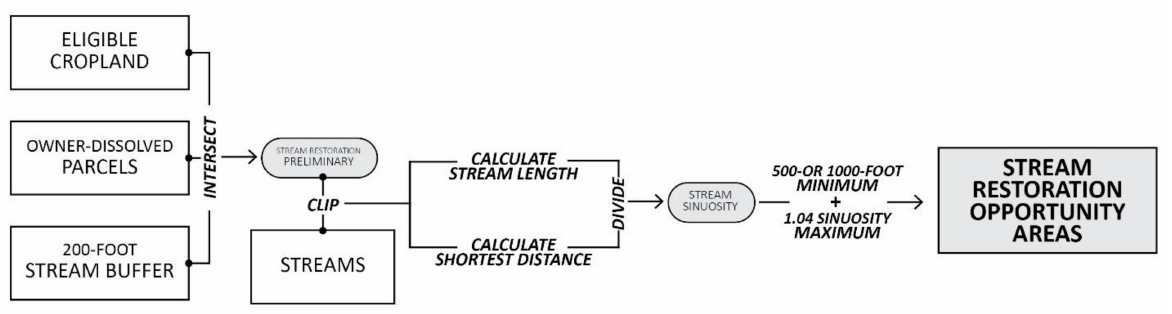
Figure 9. Diagram illustrating the general process of geospatial analysis for identifying Stream Restoration opportunities.